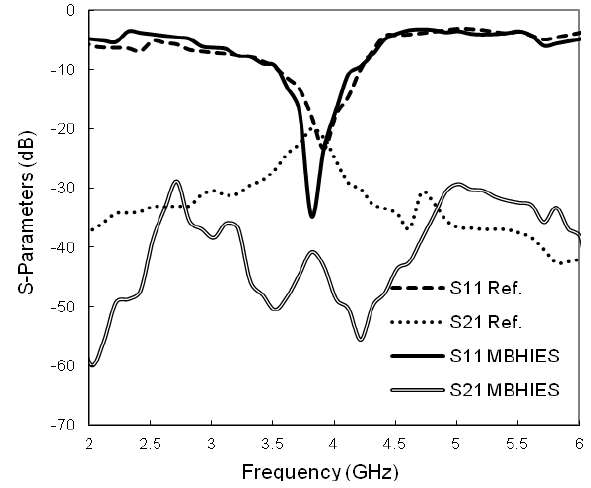
Figure 8. Simulated S- parameters of the microstrip antenna